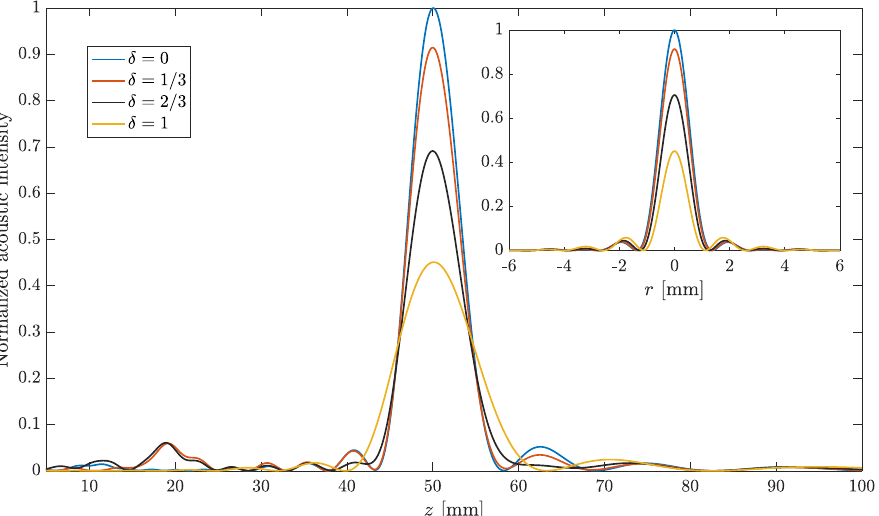
Figure 4. FZP axial focusing profiles for different predistortion parameters: δ = 0 (blue line), δ = 1/3 (red line), δ = 2/3 (black line) and δ = 1 (yellow line). The inset represents the corresponding lateral intensity profiles at z = F . Predistortion is applied to L = 7 inner